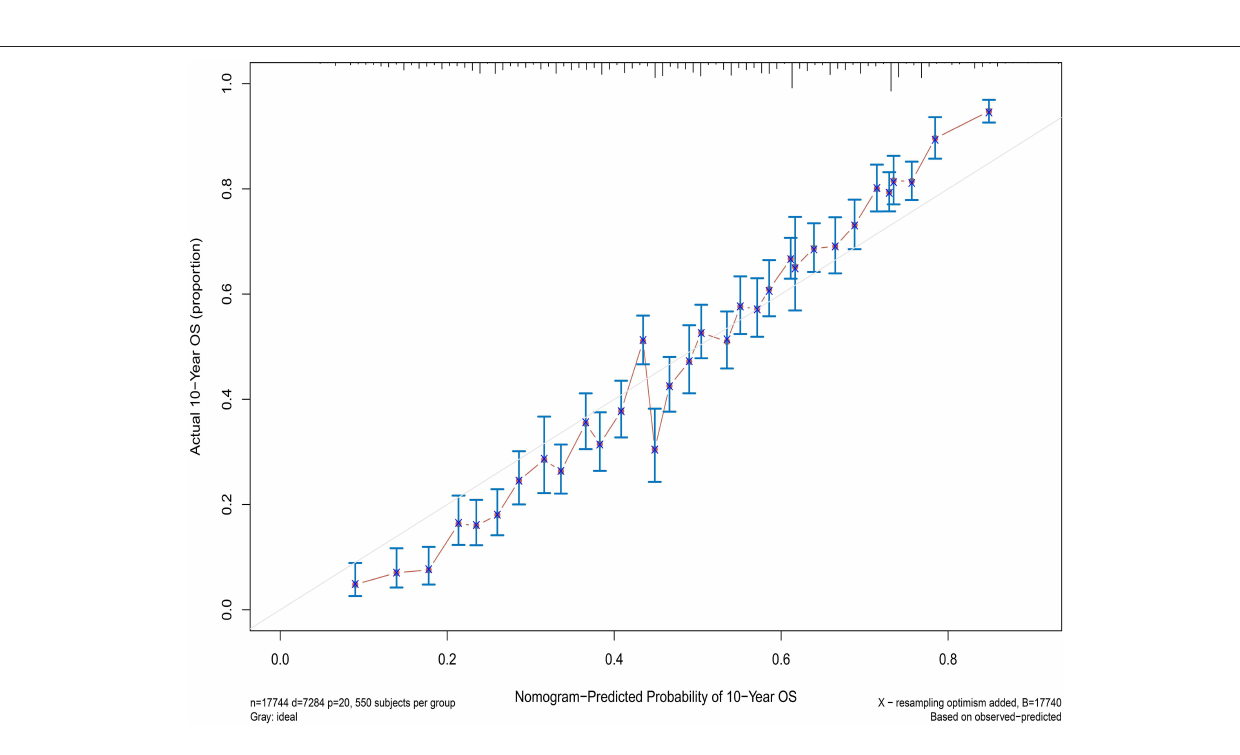
Frontiers in Oncology |